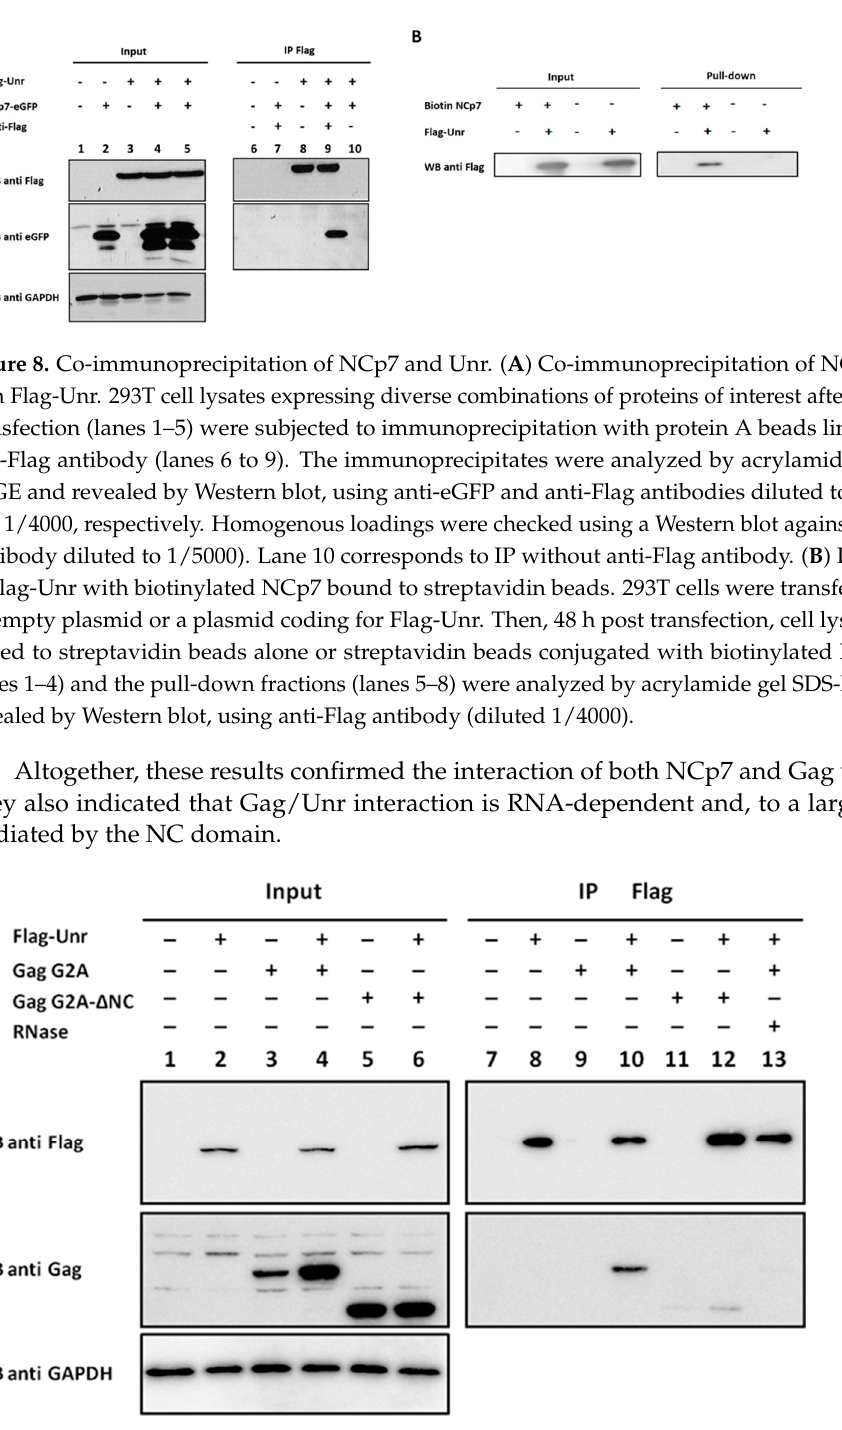
Figure 9. Co-immunoprecipitation of Gag G2A with Flag-Unr. 293T cell lysates expressing proteins of interest after transient transfection (lanes 1 to 6) were subjected to immunoprecipitation with anti-Flag antibody (diluted to 1/4000) conjugated to protein A beads. The immunoprecipitates were analyzed by acrylamide gel SDS-PAGE and revealed by Western blot, using anti-Gag antibody (diluted to 1/10,000) (lanes 7–13). In lane 13, the lysate was incubated for 30 min at room temperature with 100 μ g/mL of RNAse A before addition of the antibody. Homogenous loadings were checked using a Western blot against GAPDH (diluted to 1/5000) (lanes 1–6).